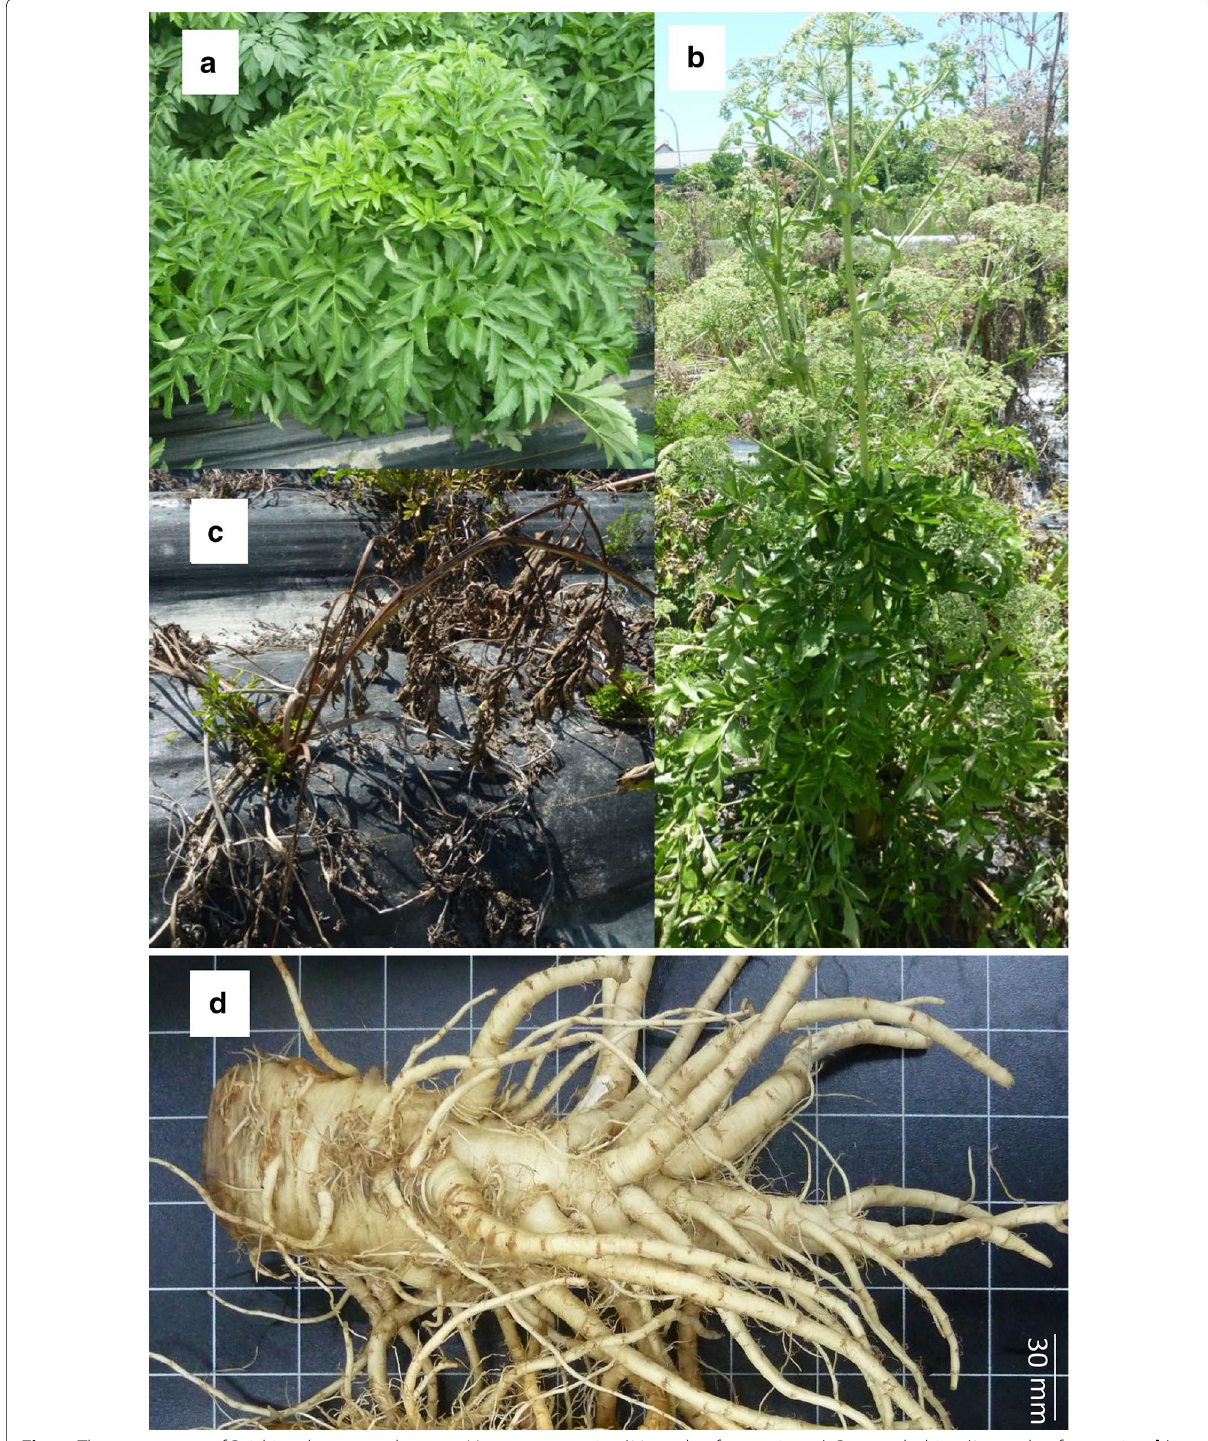
Fig. 1 The appearance of Baizhi at three growth stages: V‑stage, vegetative (23 weeks after sowing, a ); B‑stage, bolting (34 weeks after sowing, b ); S‑stage, summer dormancy (38 weeks after sowing, c ); and roots harvested at V‑stage ( d